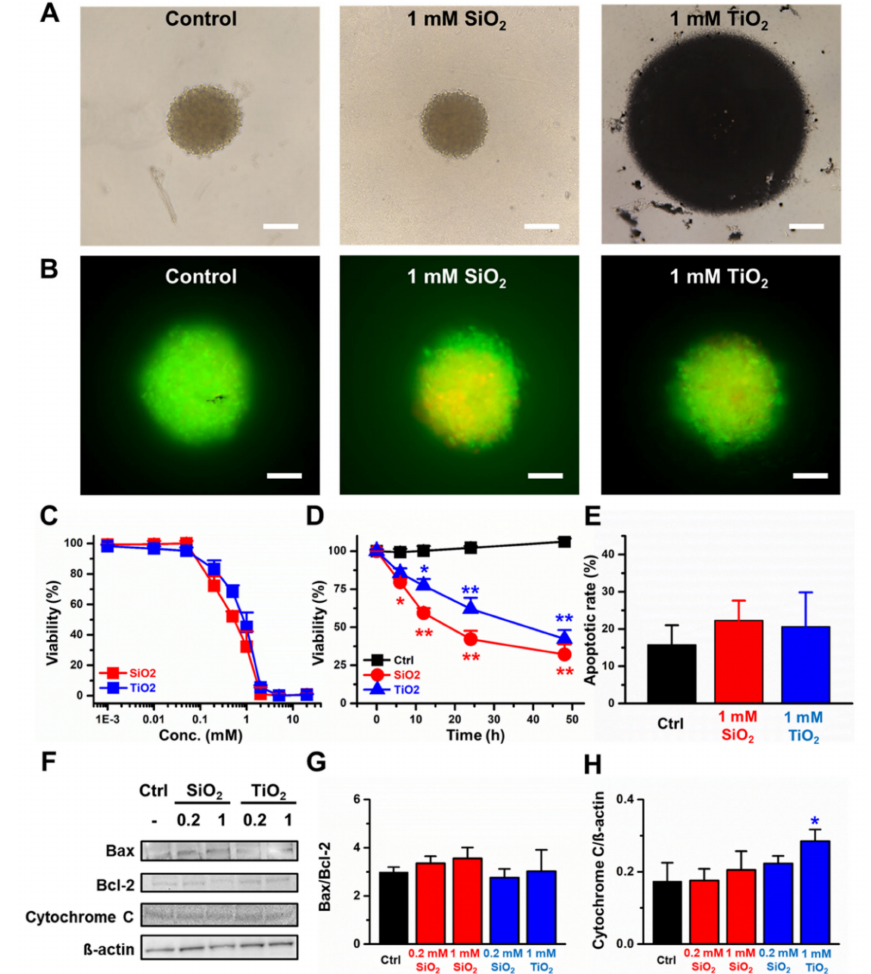
Figure 3. Cytotoxicity induced by the SiO 2 and TiO 2 nanoparticles in the 3D CCD-18Co spheroids. ( A ) Bright field images of control-SiO 2 nanoparticle-and TiO 2 nanoparticle-incubated CCD-18Co spheroids. The scale bar represents 0.2 µ m. ( B ) Live / dead assay (Green: live cells, Red: dead cells). Scale bars represent 20 µ m. ( C ) Concentration-dependent viability, ( D ) Incubation time-dependent viability. ( E ) % of cells undergoing apoptosis. ( F ) Western blot. ( G ) Quantitative analysis of the Bax / Bcl-2 protein expression ratio. ( H ) Quantitative analysis of the cytochrome C / ß-actin ratio of 3D CCD-18Co spheroids treated with the SiO 2 and TiO 2 nanoparticles. Error bars represent the standard deviation of three replicates. * For p < 0.05, ** for p <